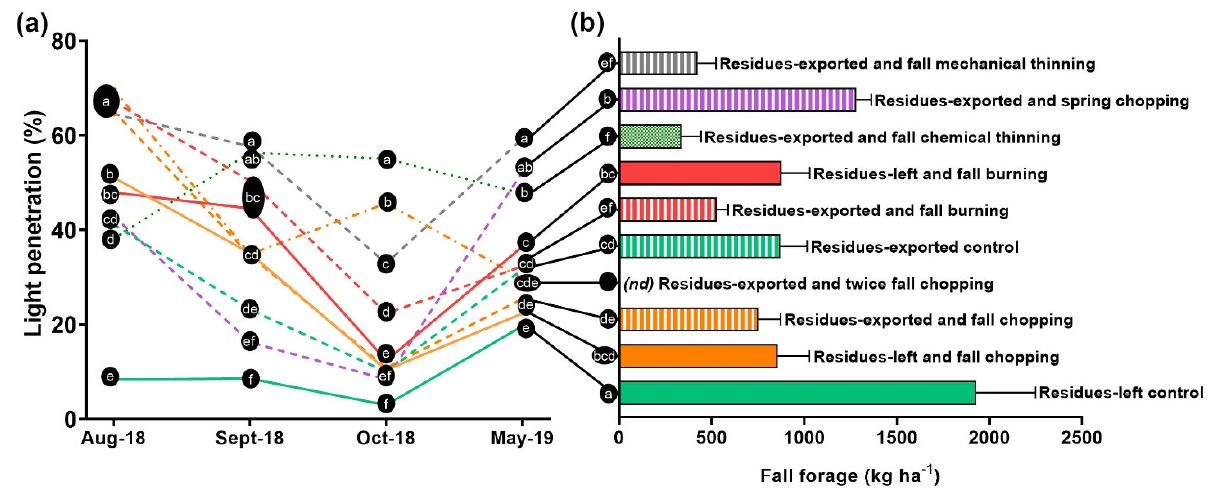
Figure 1. Percentage of light penetration to a height of 2 cm above the soil surface at four times after management treatments ( a ). Forage biomass in October 2018 ( b ). In both panels, different letters show significant differences among the treatments at each time. Black lines connect fall forage references with light penetration data.